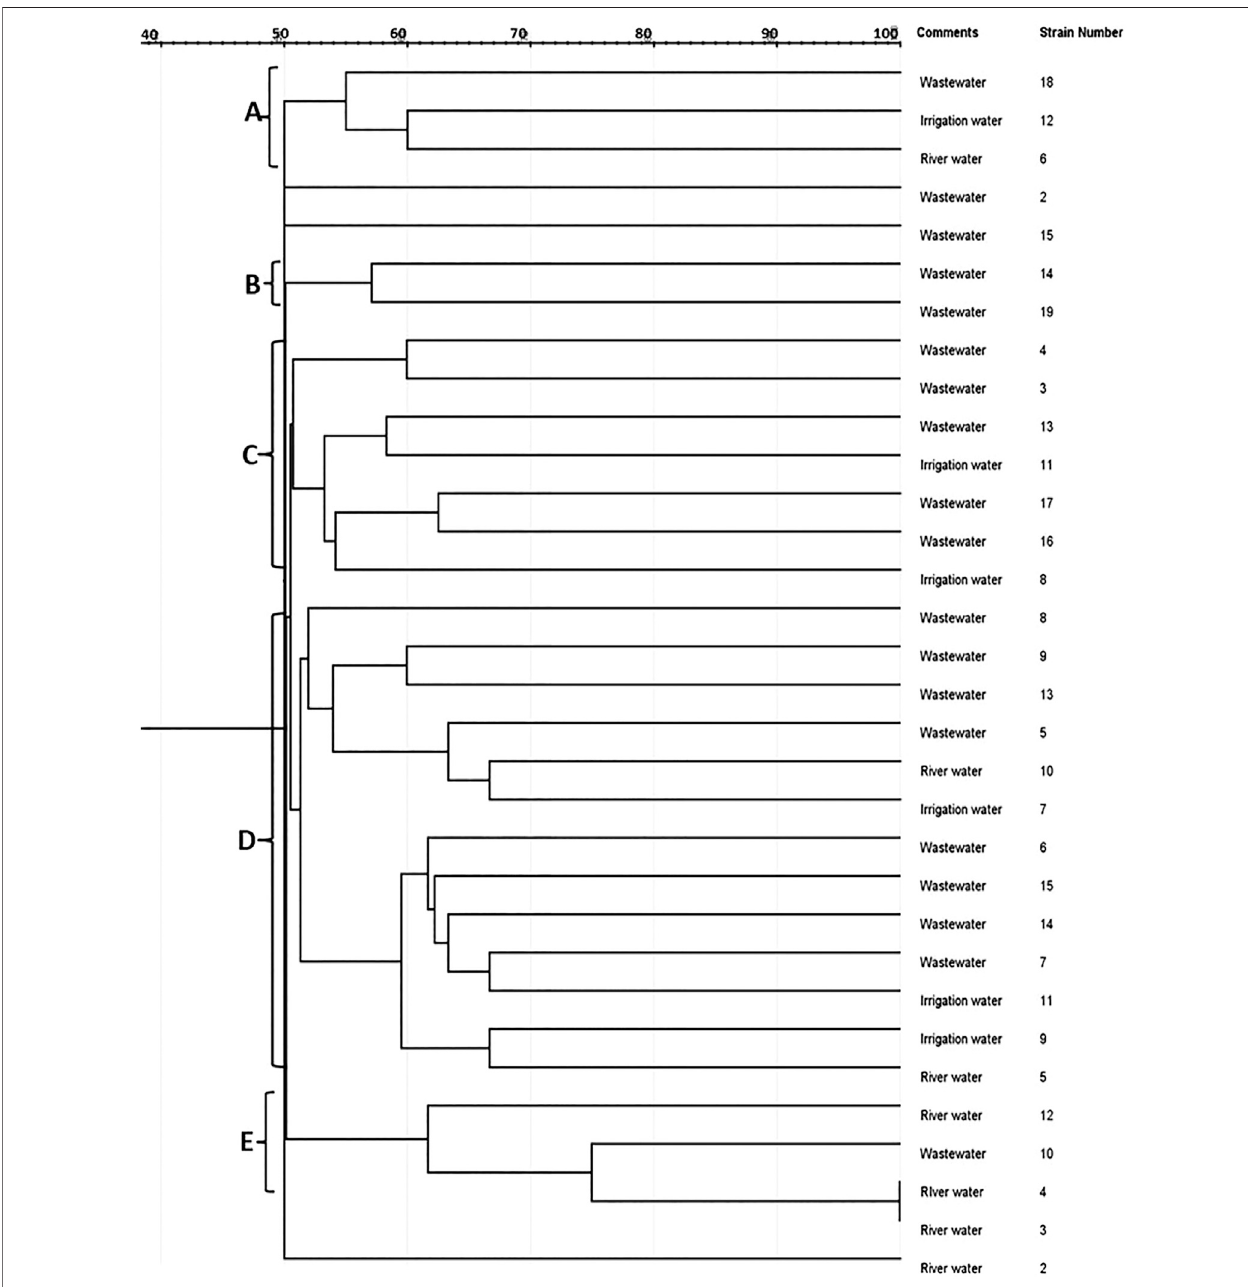
Frontiers in Environmental Science |